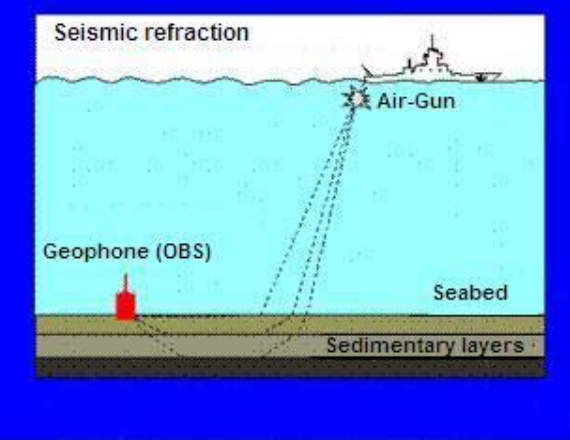
Figure 5. Schematic of a marine seismic refraction (controlled source)